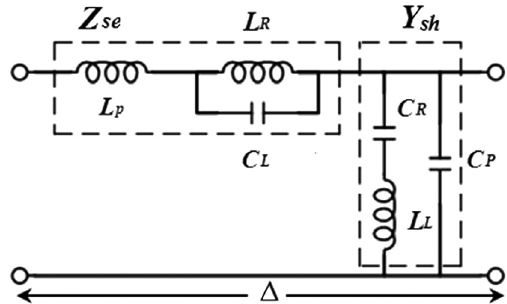
Figure 1. Unit-cell of artificial double-Lorentz (DL) transmission line (TL).